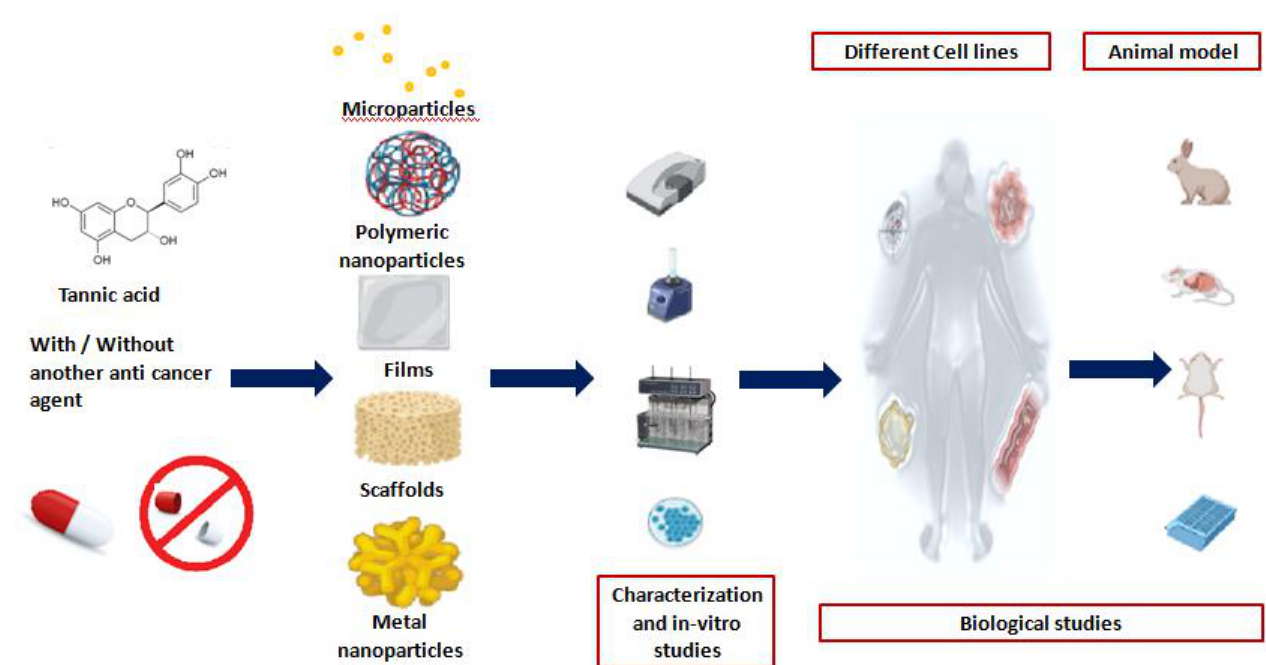
Figure 3. Steps of pharmaceutical investigation including preparation, characterization and evaluation of versatile TA-based pharmaceutical formulations using in vitro - and in vivo -based assays.